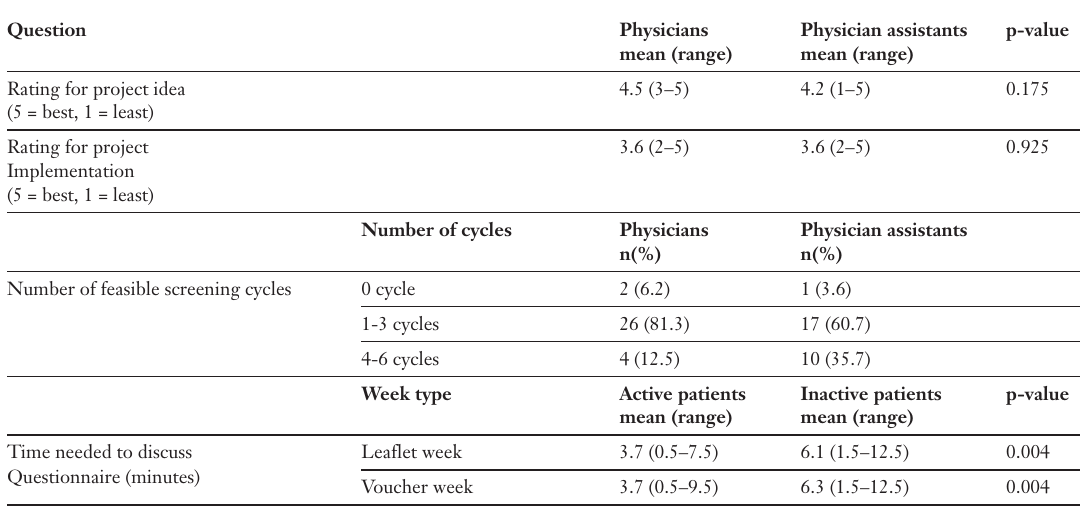
Table 2 Results of the inter- views conducted with participating physicians and prac- tice